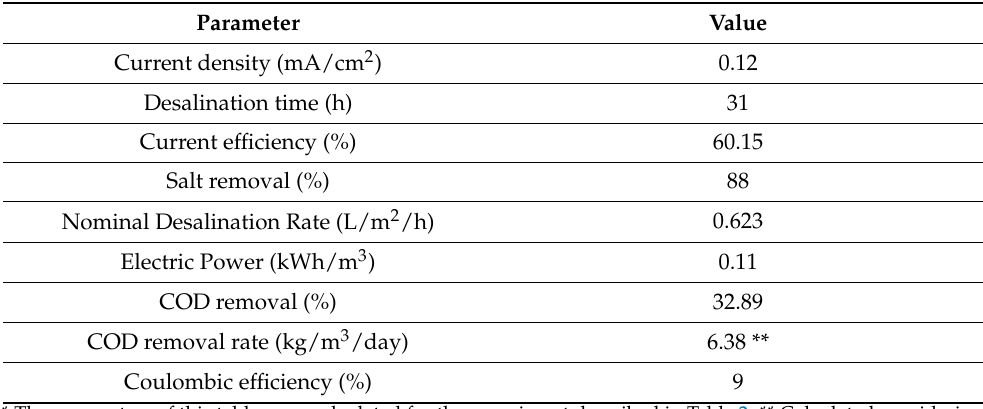
Table 3. Performance parameter for the algae-assisted MDC